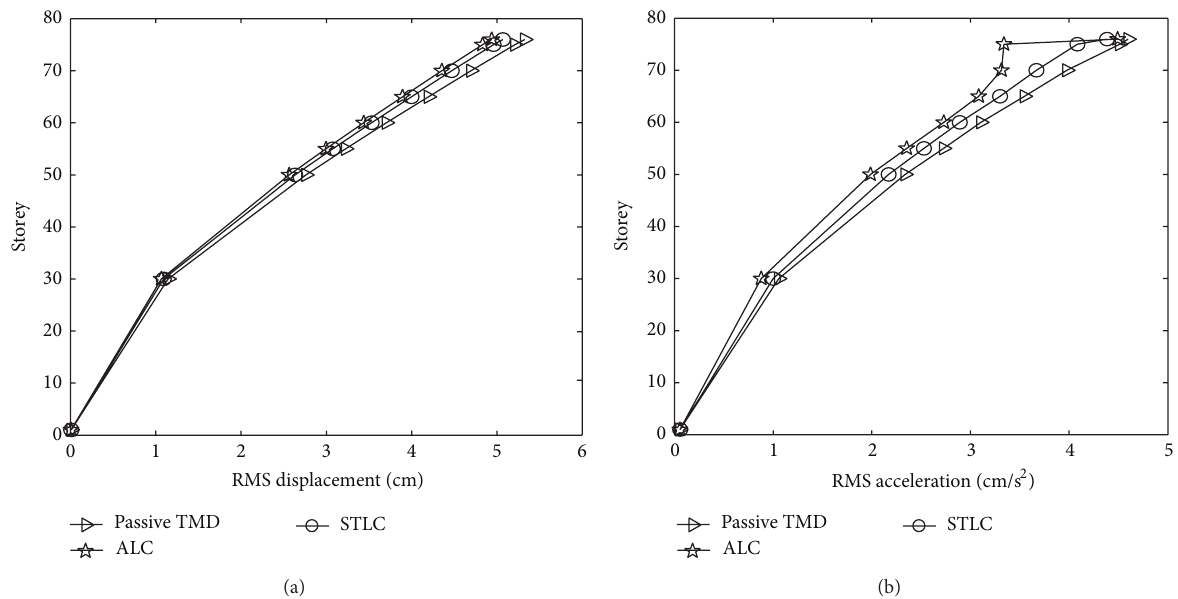
Figure 10: Comparison of RMS displacement and RMS acceleration ( 15 % stiffness